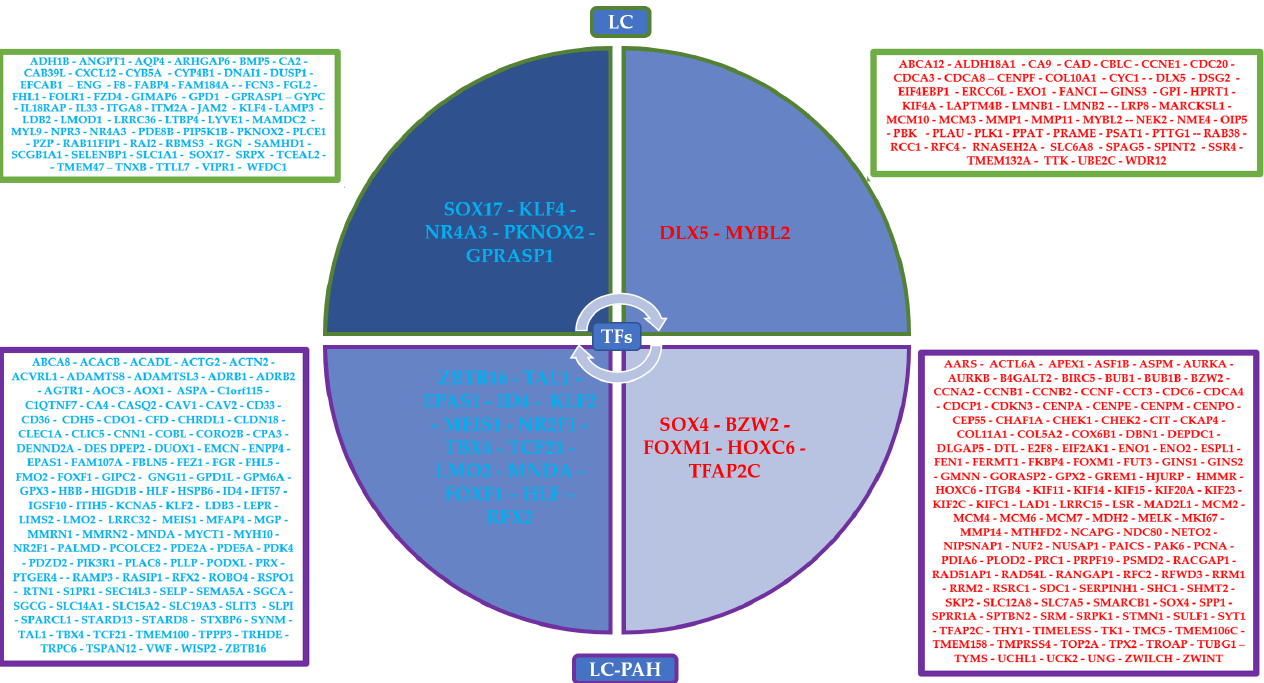
Figure 4. Cycle matrix with the winning transcription factors (TFs) and most frequently dysregulated differentially expressed genes (DEGs) inside the squares. Downregulated TFs and DEGs are in blue, and upregulated TFs and DEGs are in red. Those unique to lung cancer (LC) are in a green outline, and those shared by lung cancer and pulmonary arterial hypertension (LC-PAH) are in a purple outline.